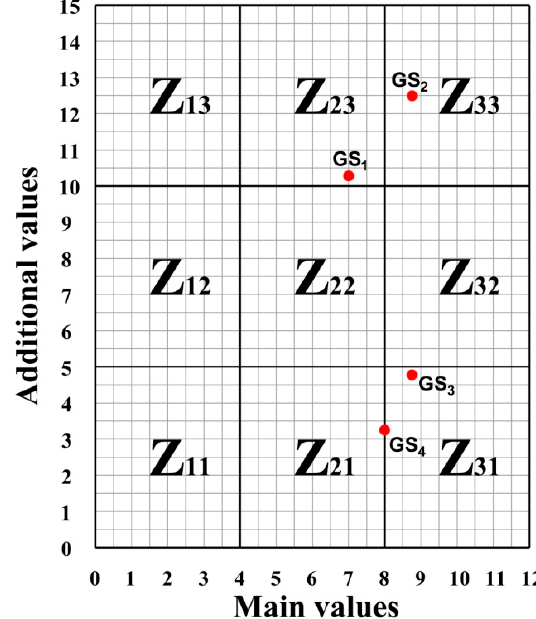
Figure 8. Location of estimated geosites in the GAM matrix.